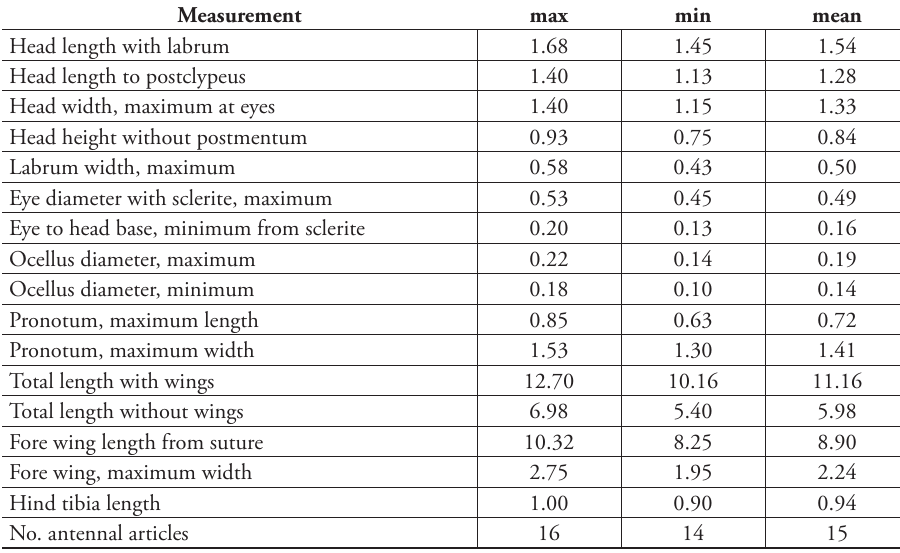
Table 3. Measurements of Neotermes agilis imago (n=10). Measurement